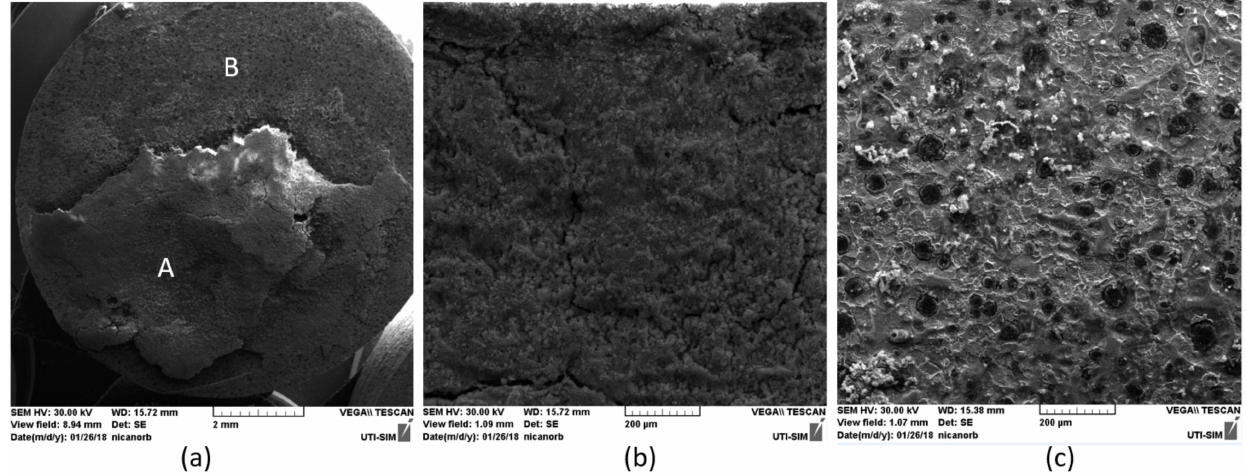
Figure 16. SEM microphotographs of the nodular cast iron surface after immersion for 65 days in DWW-1: ( a ) 25 × magnification, ( b ) and ( c ) 200 ×